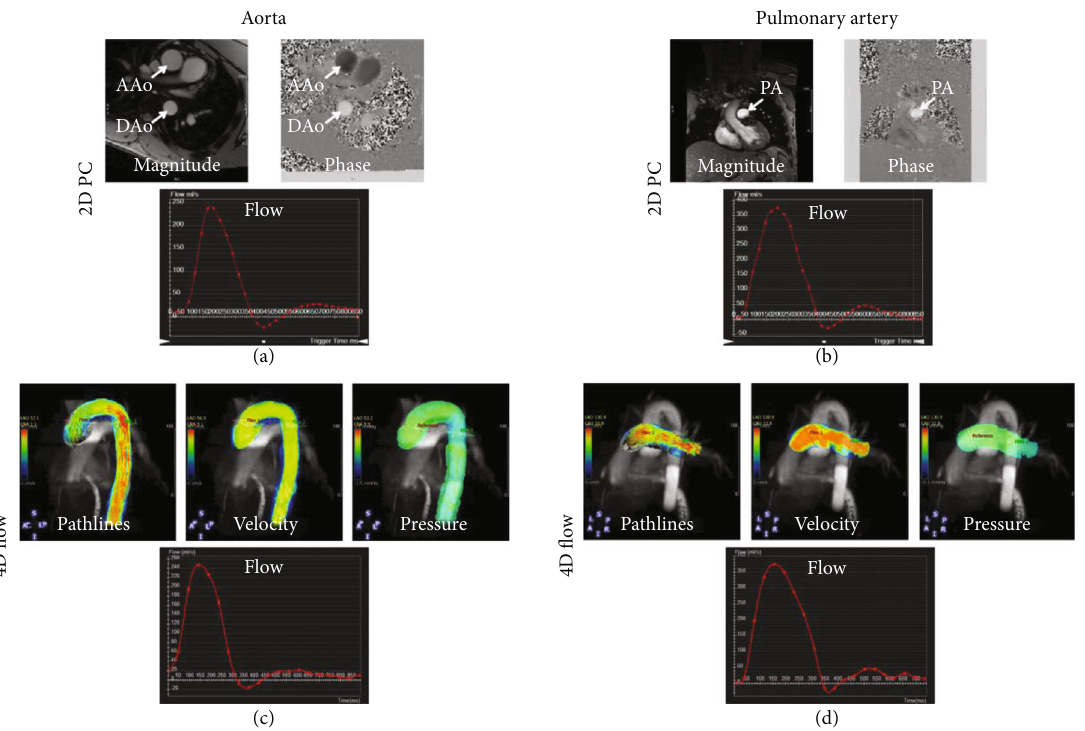
Figure 4: 2D phase-contrast and 4D- fl ow imaging in large arteries. Representative 2D phase contrast (PC) images and fl ow curves (a, b) and the corresponding 4D- fl ow maps and curves (c, d) at di ff erent measurement sites of the aorta (a, c) and pulmonary artery (b, d). The images show good agreement between fl ow curves by the two techniques, in addition to the extra information and (pathlines, velocity, and pressure maps) provided by 4D- fl ow acquisition. AAo: ascending aorta; DAo: descending aorta; PA: pulmonary